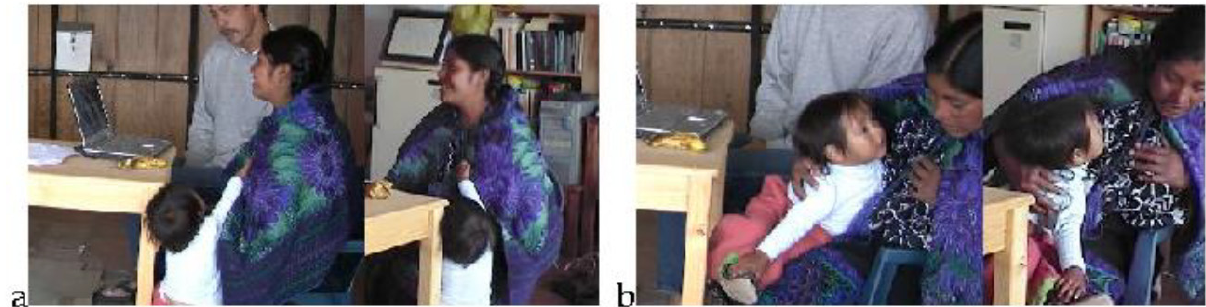
Figure 15 . ( a ) Touching, pulling, and ( b ) grabbing for attention. Figure 15. ( a ) Touching, pulling, and ( b ) grabbing for